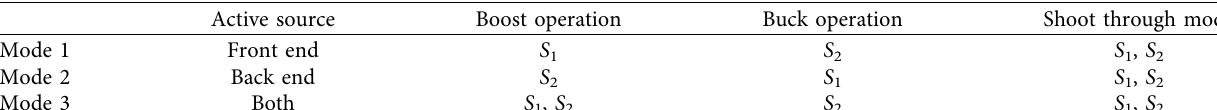
Table 1: Switching